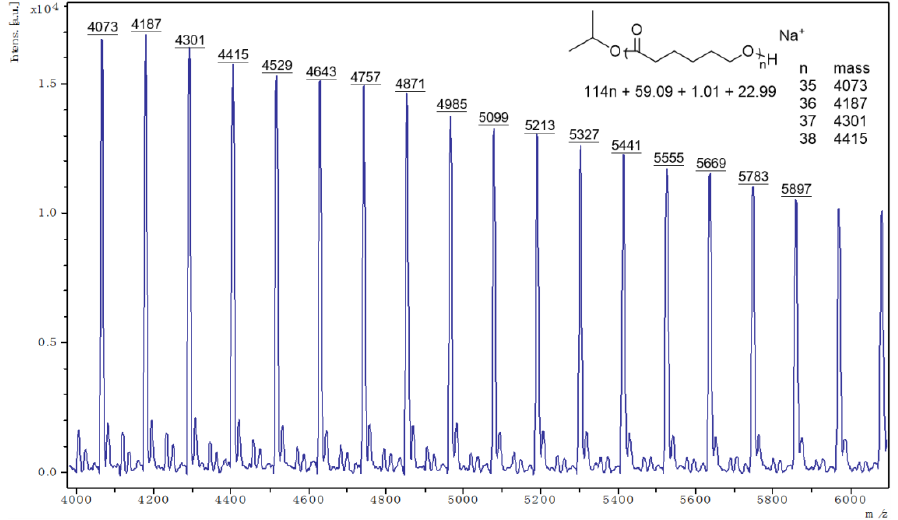
Figure 13. MALDI-TOF mass spectrum of PCL prepared using 8 (Table 1, entry 8).